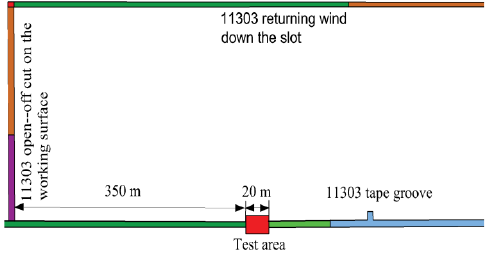
Figure 15. Test area of 11303 belt chute.